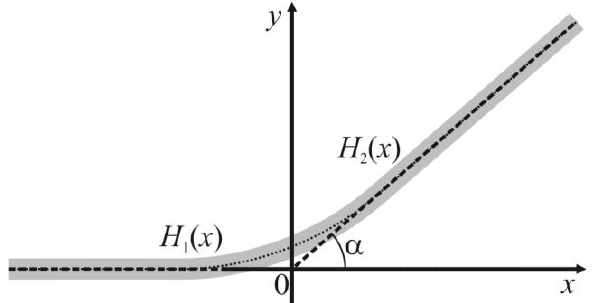
Figure 2. The structure of the transition zone at the point of the meeting between bilayers of the phases A and B . The membrane is shown as a gray stripe. The angle between the tangent planes of two meeting bilayers is α = α A – α B . The tangent planes meet at the origin of the Cartesian coordinate system. The shape of the membrane in the half-space x < 0 is described by y -coordinates of points of the membrane surface, function H 1 ( x ); at x > 0 — by the function H 2 ( x ). The functions H 1 ( x ), H 2 ( x ) are conjugated at x = 0 based on the continuity of the membrane surface, as well as continuity of its first and second derivatives with respect to x .